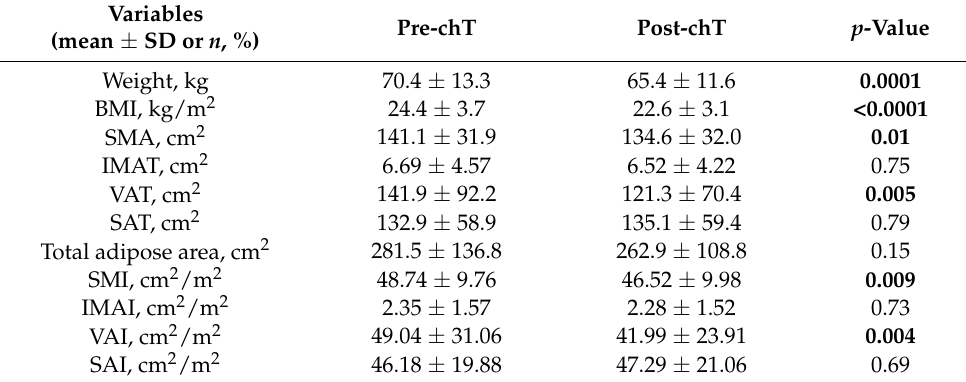
Table 2. Body composition variations between pre- and post-chemotherapy in patients ( n = 26) following FLOT chemotherapy for gastric cancer.